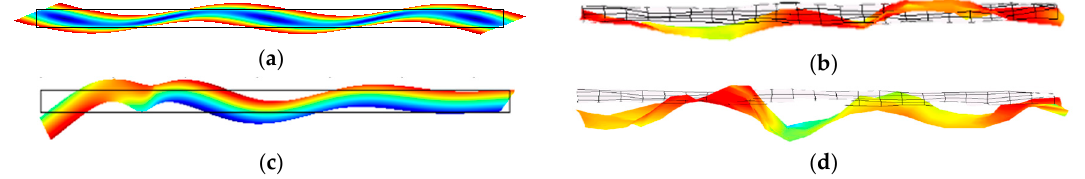
Figure 3. Displacement pattern of Y-cut GaPO 4 transducer at 100 kHz for parallel electrodes ( a ) modelled and ( b ) measured; and with wrap-around electrodes ( c ) modelled and ( d )